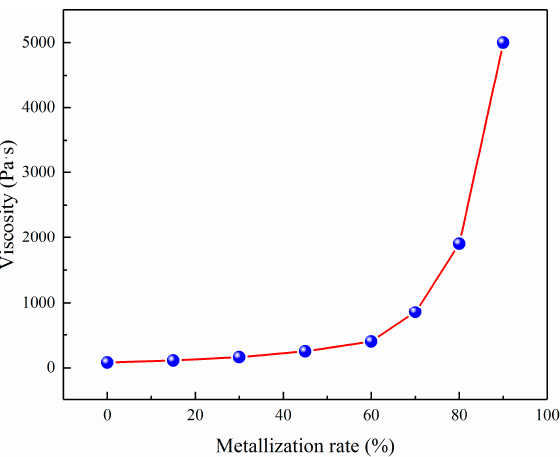
Figure 15. The viscosity of metallic particles in different metallisation rates at the temperature of 1573 K.